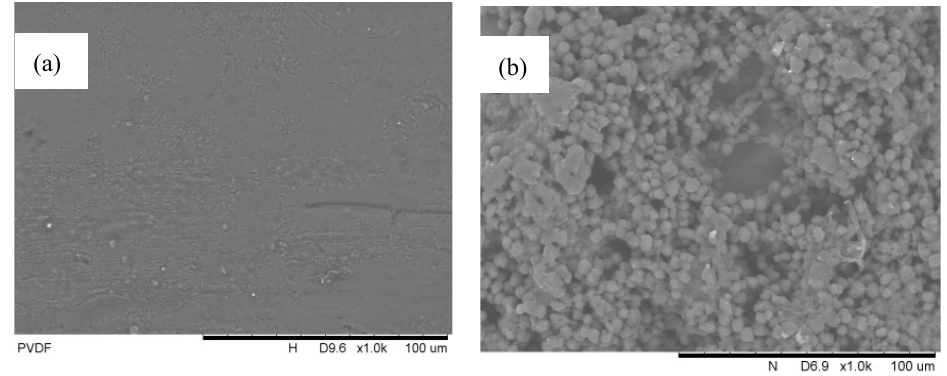
Figure 2. SEM surface morphology images of the pristine membrane ( a ) and 10 mg mL − 1 -polypropylene (PP)-concentration PVDF hollow fiber membrane PVDF ( b ) at a 1000× magnification without the non-solvent.